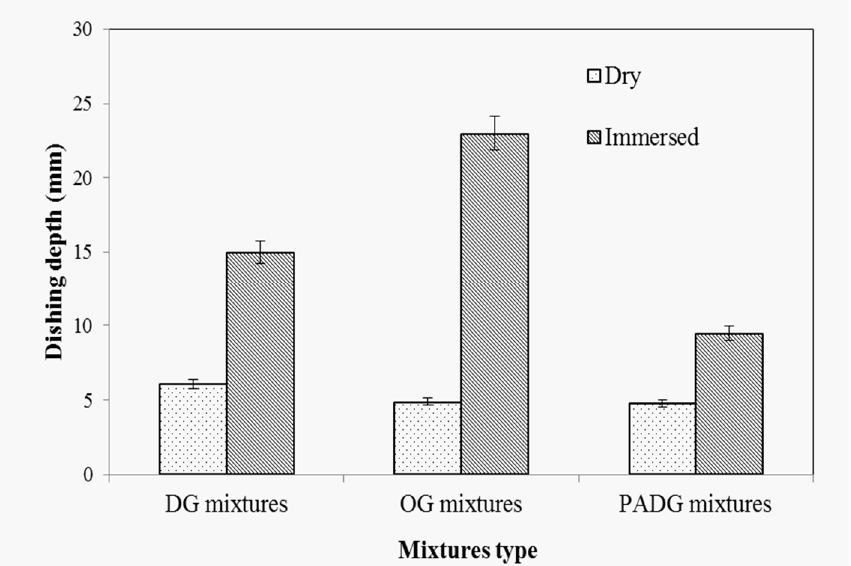
Figure 11. Accelerated loaded test results of DG mixtures, OG mixtures, and PADG mixtures in dry